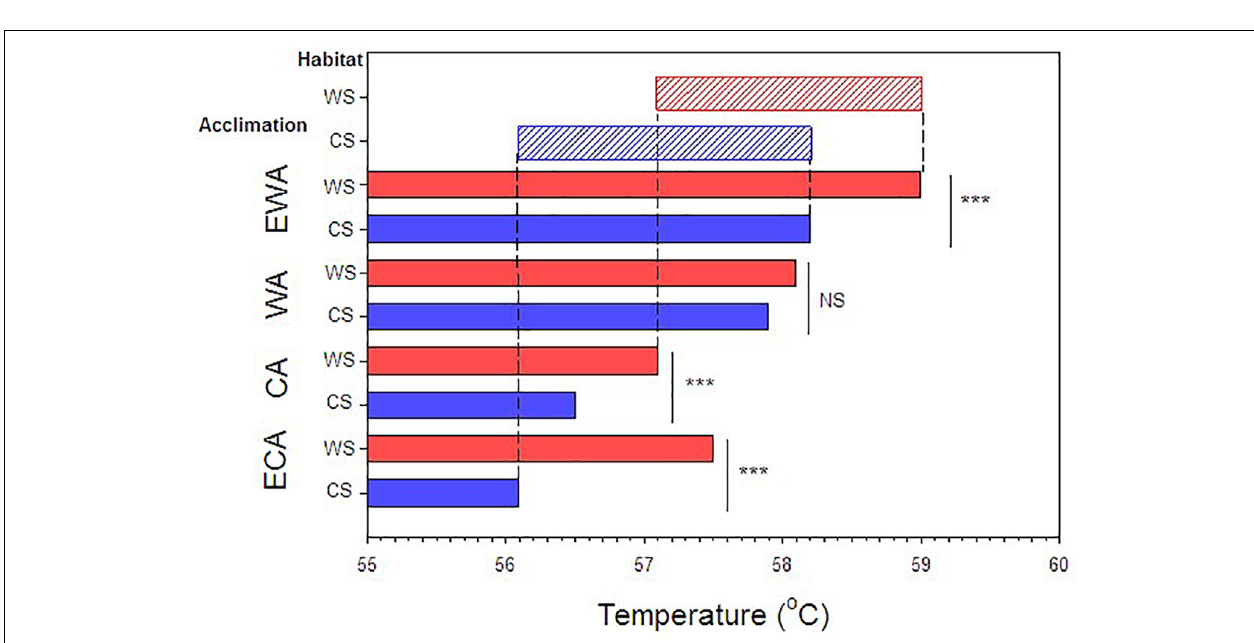
FIGURE 4 | Compilation of results showing the LT 50 values for the various acclimation and acclimatization (habitat) conditions. Red bars indicate warm shore acclimatization (WS) and blue bars, cool shore acclimatization (CS). ECA, CA, WA, EWA refer to extra-cool, cool, warm and extra-warm acclimation, respectively. Asterisk indicates P < 0.01 and NS, non-significant difference. Lightly shaded upper bars indicate acclimation capacities and ranges for warm shore (red) and cool shore (blue) acclimatized snails.